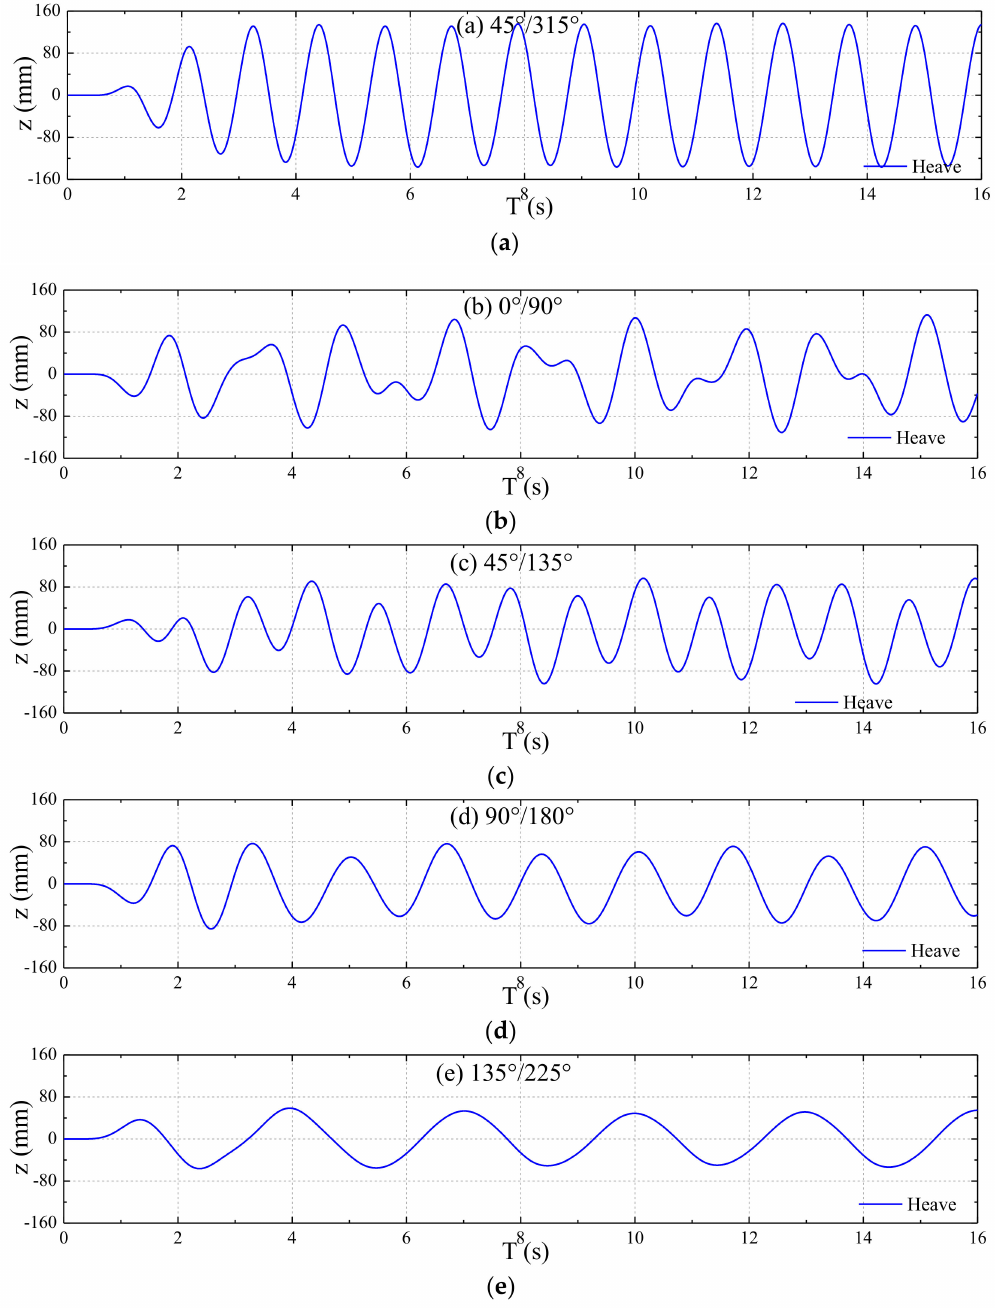
Figure 16. Time series of ship heave motion in di ff erent wave headings: ( a ) 45 ◦ / 315 ◦ (Case 4); ( b ) 0 ◦ / 90 ◦